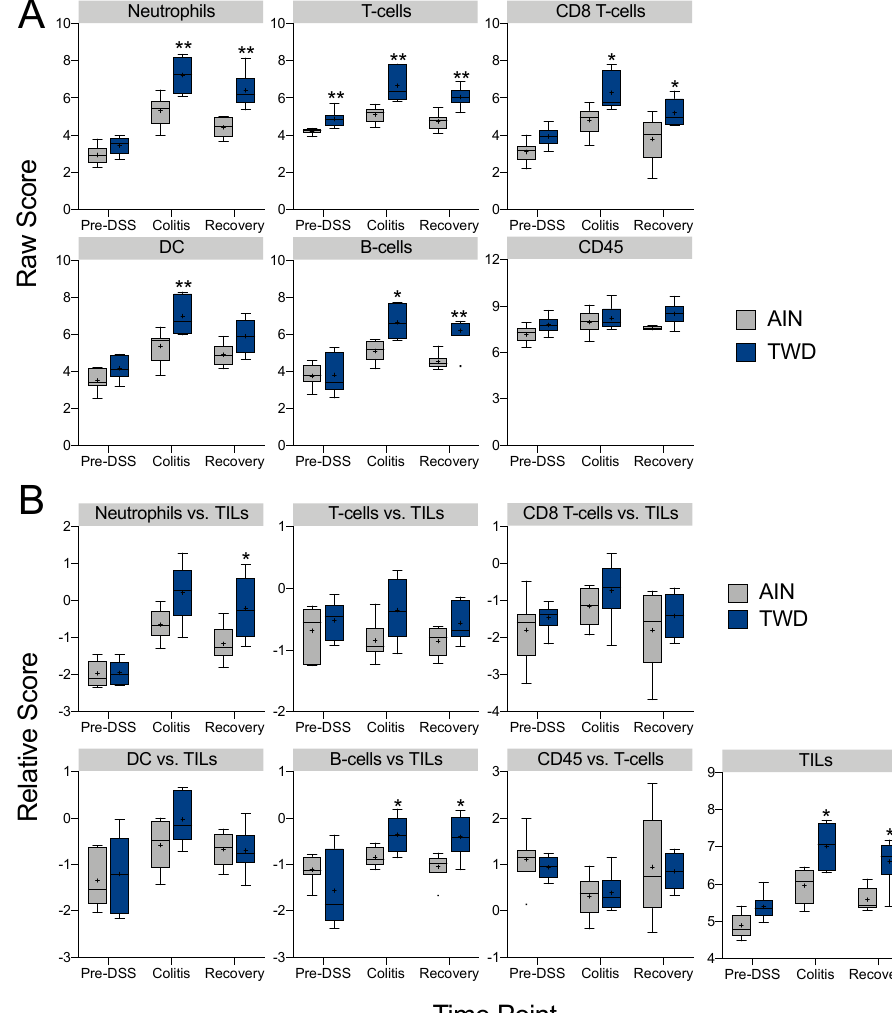
Figure 11. Profiling of immune cell types in colon tissues obtained at pre-DSS, colitis or recovery time points from mice fed either AIN or TWD. ( A ) Data shown are the log 2 scores for the indicated cell types, and only those cell types that met quality control testing for correlation of marker gene expression ( p < 0.05) are shown. Scores may be compared within a cell type for both diet and time point, but comparisons across cell types are not appropriate for this method of quantitation. Scores do not convey information about the absolute number of cells in the samples. ( B ) Data shown are the relative cell type measurements with respect to total infiltrating leukocytes (TILs). * p < 0.05 and ** p < 0.01 compared to time point-matched AIN control as determined by the non-parametric Steel-Dwass test.